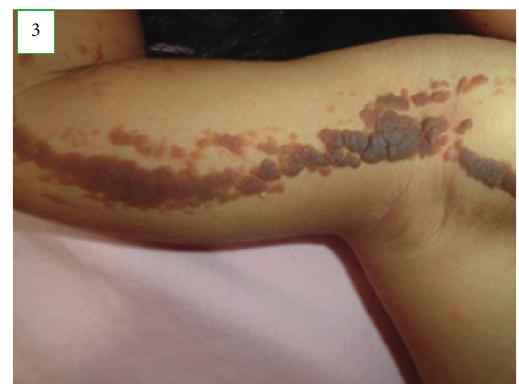
Figure 3: Skin patterns of the melanocytic and verrucous nevi.